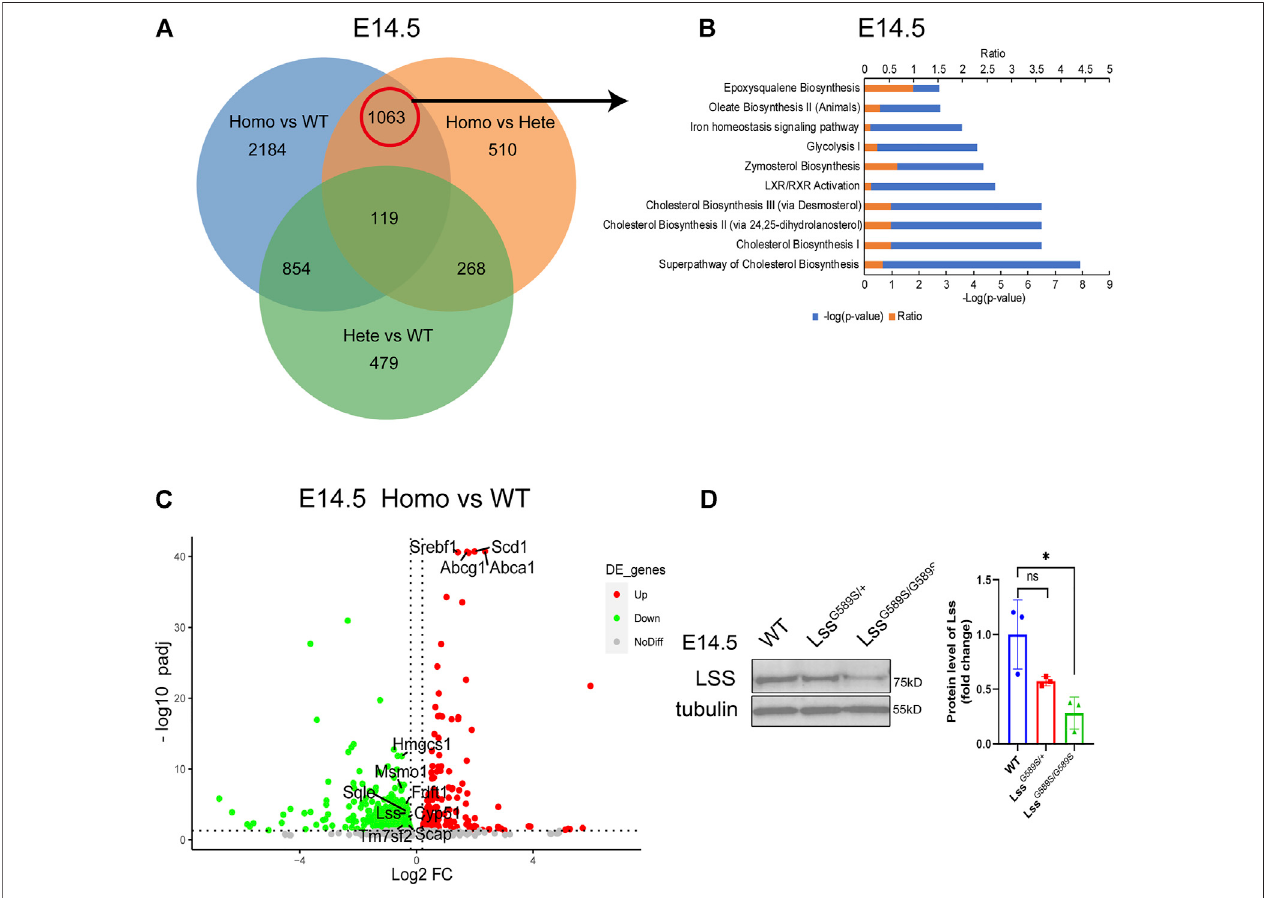
FIGURE 9 | RNA-seq pro fi ling in the lens of WT, Lss G589S/+ , and Lss G589S/G589S mice at E14.5. (A) Venn diagram analysis of differentially expressed genes (DEG) only overlapped in two groups (homozygous vs. WT, homozygous vs. heterozygous). (B) IPA pathway analysis of 1063 DEGs from the above results in (A) . Top 10 enriched canonical pathways were identi fi ed by applying the − log( p -value) > 2 threshold. Cholesterol biosynthesis pathways were signi fi cantly altered. (C) Volcano plot analysis showing downregulated and upregulated DEGs in the terms “ cholesterol biosynthesis pathway ” and “ LXR/RXR pathway ” ( p adjust < 0.05). (D) Western blot analysis of Lss from the lens of WT, Lss G589S/+ , and Lss G589S/G589S mice at E14.5. Anti-tubulin immunoblot was used as the reference. Statistics of Western blot (right) , n (cid:1) 3 embryos per group. The data represent mean ± SEM. Signi fi cance was determined by two-tailed, unpaired Student ’ s t test. ns: no signi fi cance. * p < 0.05 versus WT